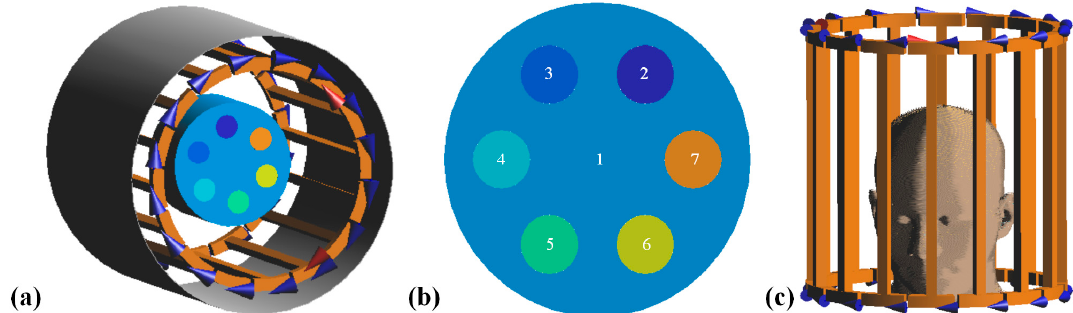
Figure 1. Simulation setup. ( a ) The birdcage coil loaded with a numerical phantom, ( b ) seven regions of phantom, ( c ) the birdcage coil loaded with the Ella model. The radiofrequency (RF) shield is not shown in ( c ).